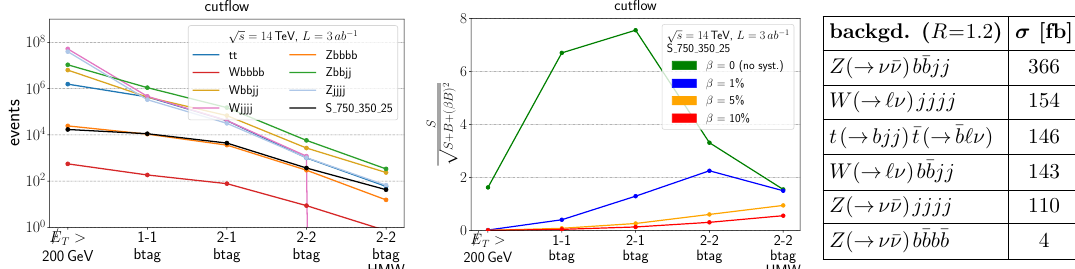
Figure 5 . Cut(cid:13)ow for number of events (left panel) and signi(cid:12)cance (cid:6) (center panel) for the cut-based analysis of the symmetric model S 750 350 25. Right panel: cross section of dominant backgrounds for =E > 200 GeV, after applying a lepton veto and requiring 1-1 b -tagging, i.e., at T least one b -tagged subjet from each fat jet with radius R = 1 :